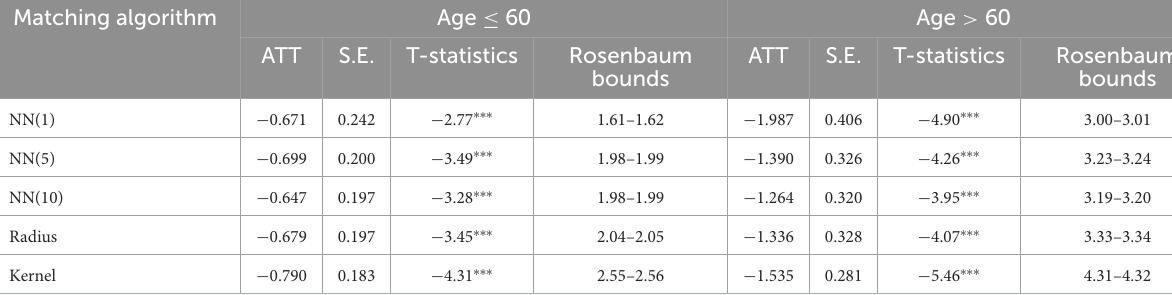
TABLE 5 Heterogeneity in health impacts of internet use by age. Matching algorithm